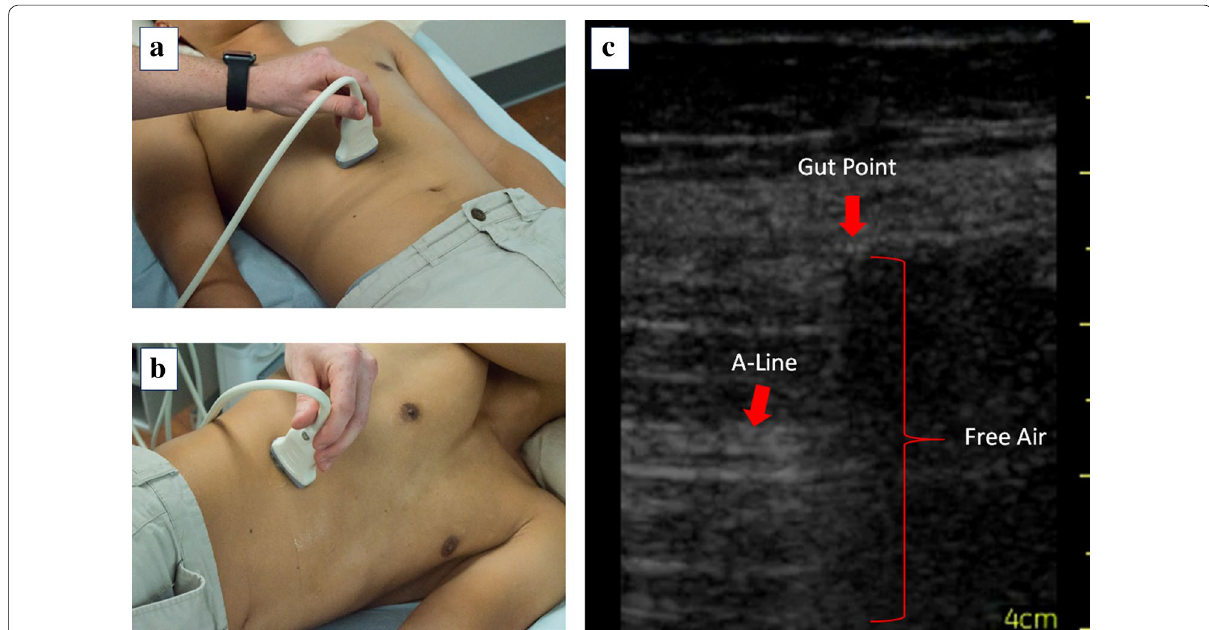
Fig. 3 a Patient placed in the supine position for an initial sonographic assessment for free intraperitoneal air. b Patient placed in the lateral decubitus position to allow free intraperitoneal air to accumulate anterior to the hepatic parenchyma. c Sonographic output of a patient with free intraperitoneal air. Air is a strong reflector of ultrasound waves. Reflection produces bright focal lines (A-lines, red arrow) with dark shadowing in